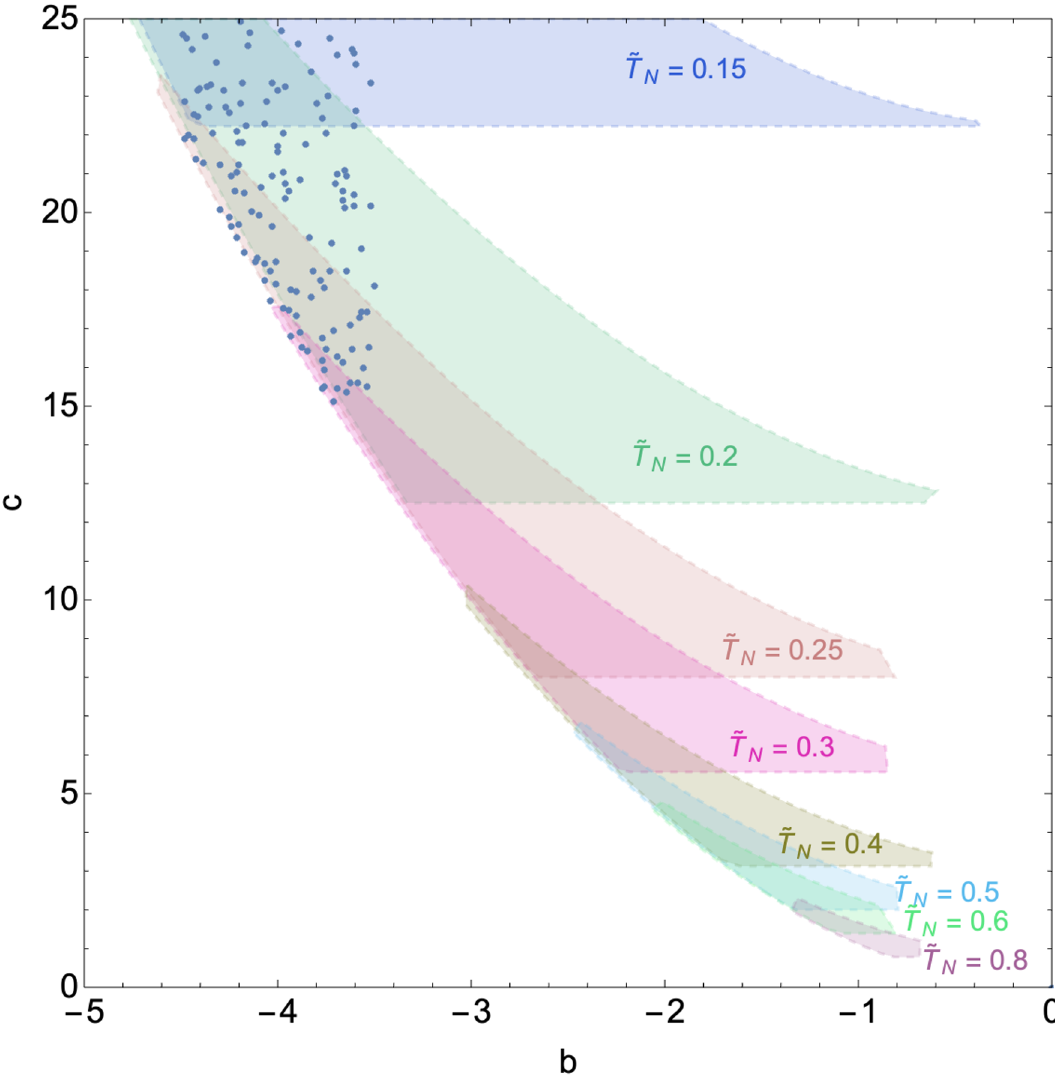
is within 2% of solid Figure 8. Plot in the ( b, c ) -plane of parameter points for which h 2 Ω max sw blue line shown in figure 7a. The shaded regions indicate regions in the ( b, c ) -plane for which various nucleation temperatures ˜ T can be N